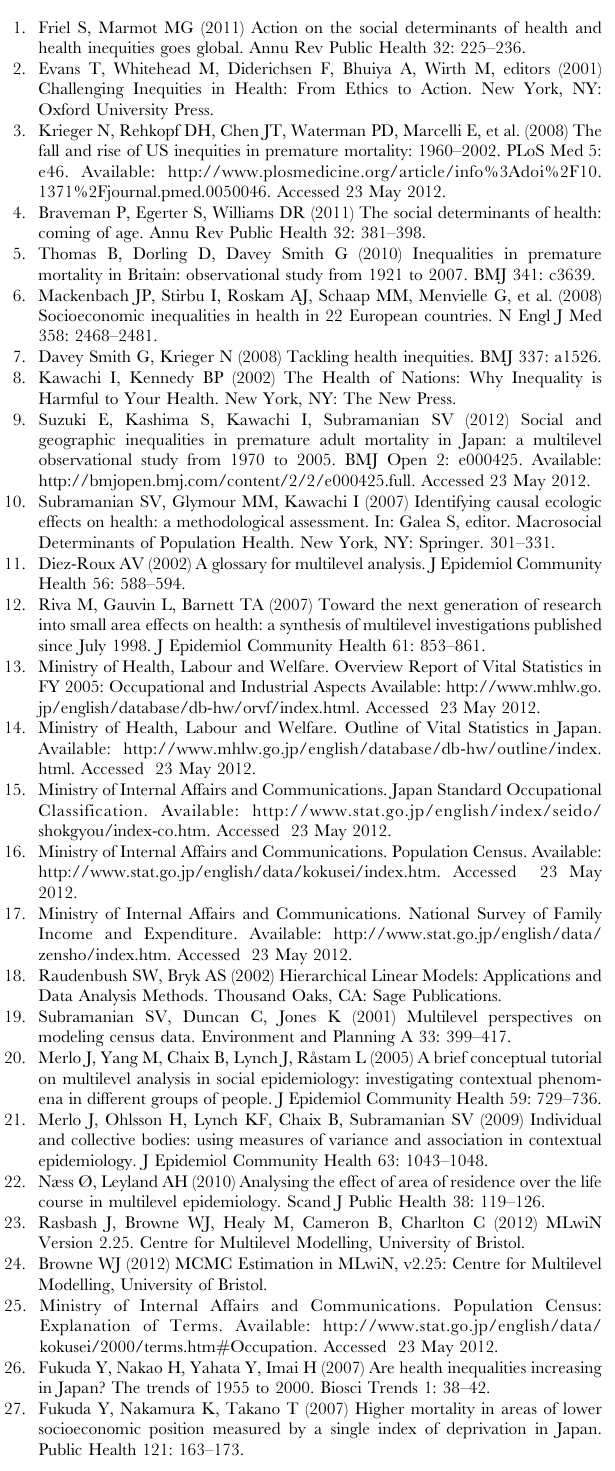
Table S6 Predicted number of all-cause mortality (per 100,000) by each occupation group, Japan,